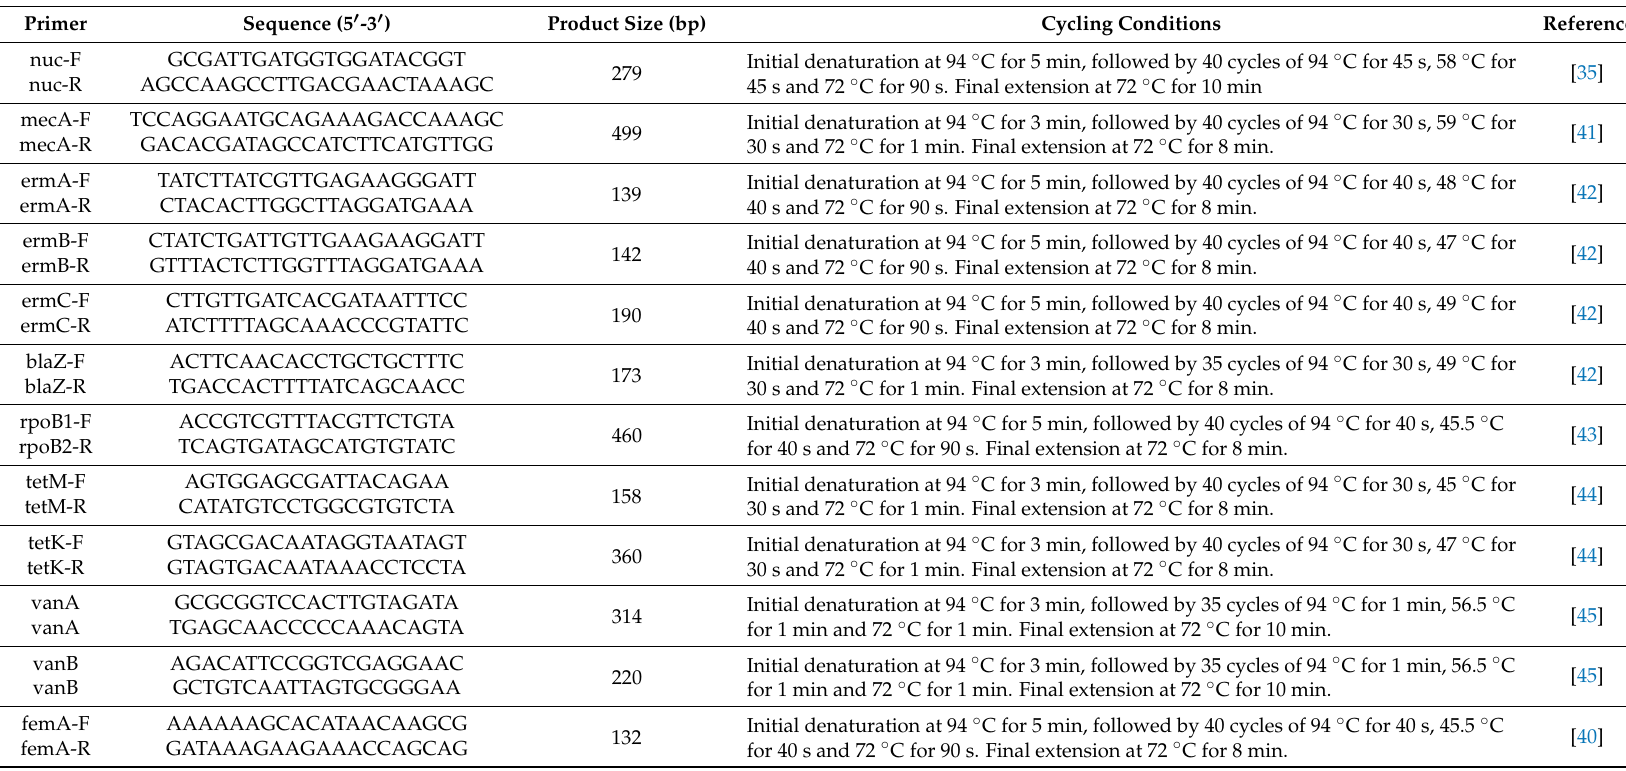
Table 1. Oligonucleotide primers and cycling conditions used in the molecular confirmation of S. aureus and antibiotic-resistance genes. Primer Sequence (5 (cid:48) -3 (cid:48) ) Product Size (bp) Cycling Conditions